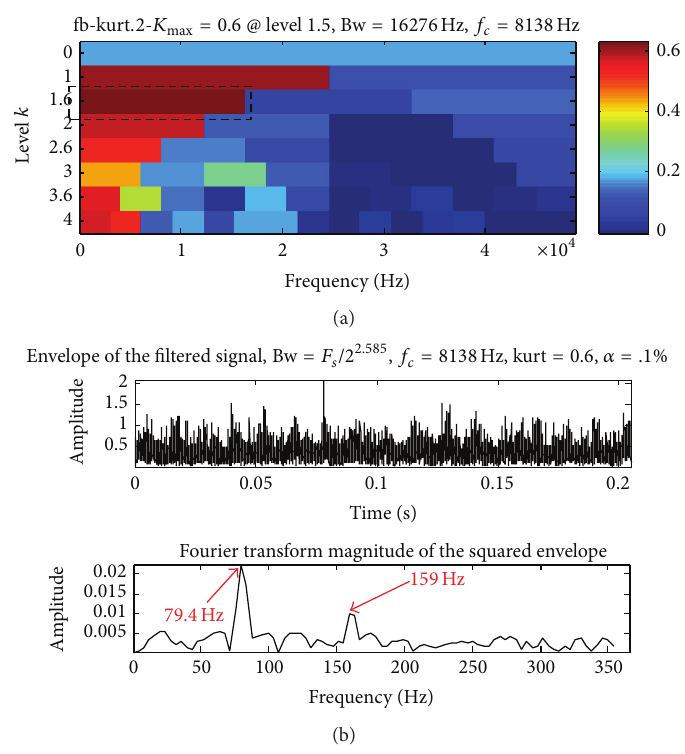
Figure 20: Analyzed results of the simulated signal shown in Figure 15(a) by the fast Kurtogram: (a) Kurtogram of the experimental signal; (b) envelope of the filtered signal and corresponding demodulation spectrum.